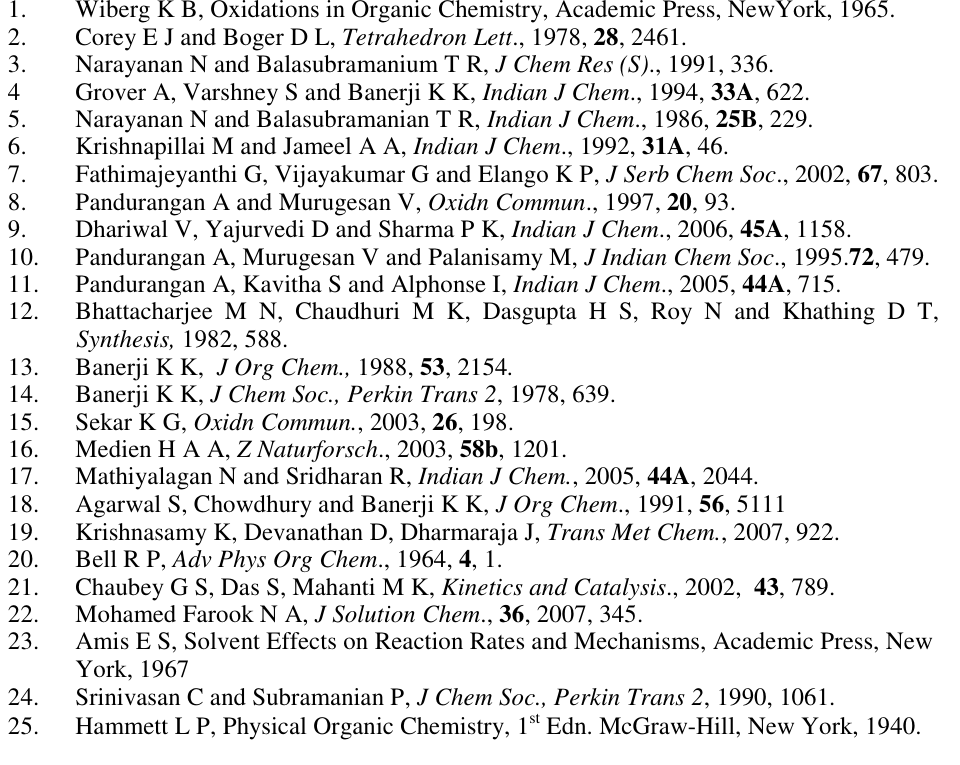
(313K) versus log k 2